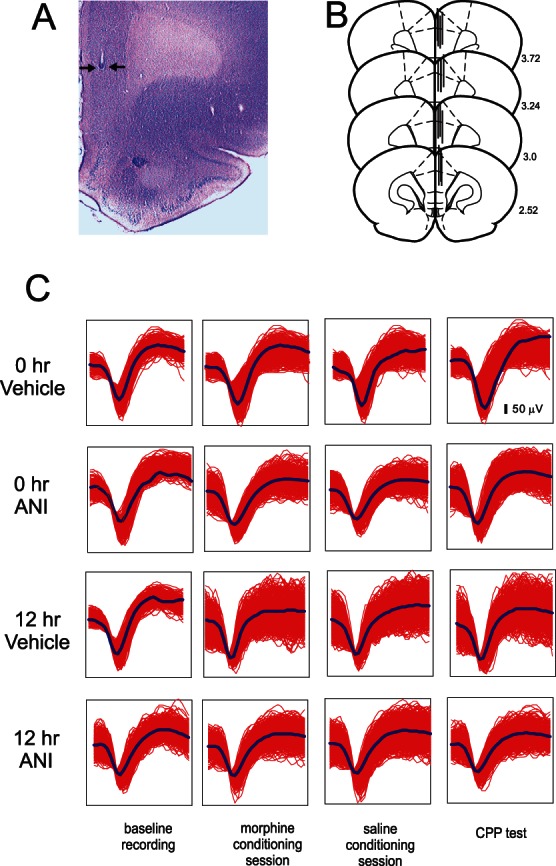
Intra-mPFC microwire recording locations, waveform analysis and effects of intra-BLA ANI on neuronal encoding of opiate reward memory.
A, Microphotograph showing a representative intra-mPFC recording wire placement (black arrows). B, Schematic representation of sample intra-mPFC microwire recording location, demonstrating rostral-caudal distribution within the mPFC. C, Sample mPFC neuronal unit waveforms from single channels, recorded over 3 days (baseline, conditioning day, CPP recall test) from four experimental groups receiving either intra-BLA vehicle ANI or vehicle at 0 or 12 hrs post-conditioning D.